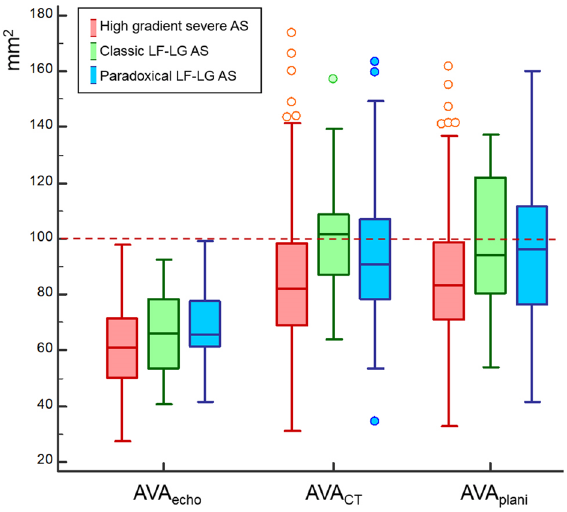
Figure 1. Box plot to demonstrate the distribution of AVA echo , AVA CT , and AVA plani according to categories of AS. AS aortic stenosis, AVA aortic valve area, LF-LG low-flow and